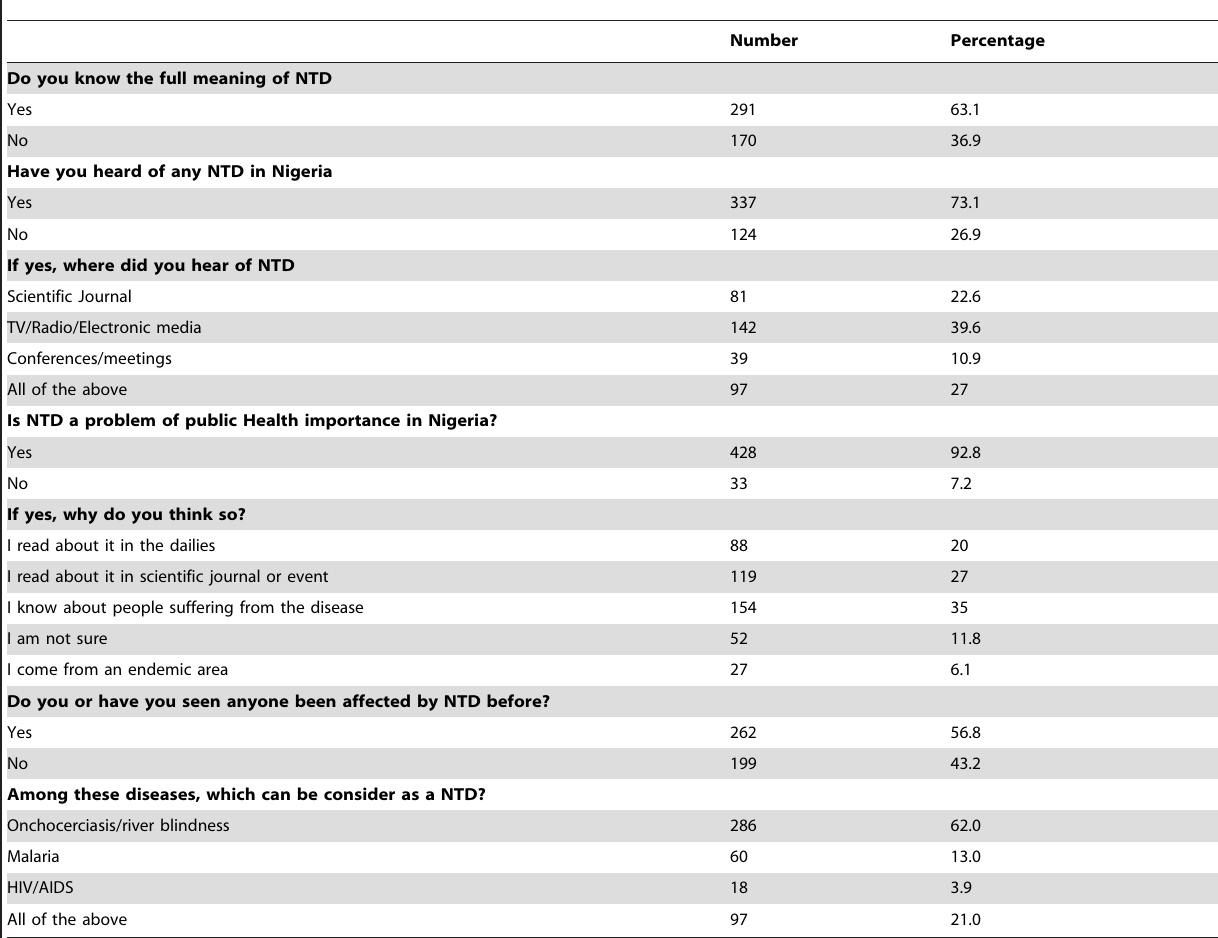
Table 2. General knowledge of the public about